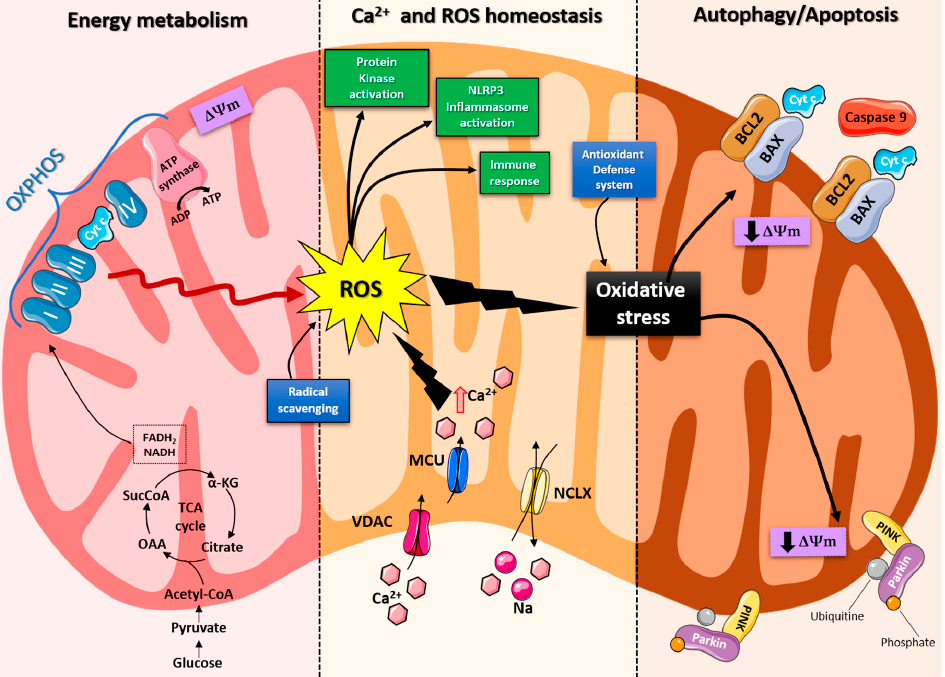
Figure 1 Figure 1. Schematic representation of the mitochondrial functions. From left: Under physiological conditions, mitochondria supply ATP through OXPHOS. Krebs cycle enzymes use acetyl-coenzyme A to reduce NADH and FADH2, which are used for energy transfer to the electron transport chain (ETC) embedded in the inner mitochondrial membrane. OXPHOS is also an important source of ROS, whose basal levels are maintained by the radical scavenging network. Mitochondria also play a crucial role in calcium homeostasis. The voltage-dependent anion channel (VDAC) and the mitochondrial Ca 2+ uniporter complex (MCU) finely control Ca 2+ passage across the mitochondrial membranes, while the mitochondrial Na + /Ca 2+ exchanger (NCLX) is one of the central units involved in Ca 2+ extrusion. Under normal conditions, through ROS generation and redox signaling, mitochondria can control cellular metabolism, physiology, the inflammatory response, and immune function and act as important signaling molecules in the cell by activating various protein kinases. In contrast, the overproduction of ROS and dysregulation of the redox signaling system result in oxidative stress that can lead to mitochondrial damage. Malfunctioning mitochondria can be selectively removed through mitophagy, or, as all other defense mechanisms fail, the neuron can orchestrate its own destruction by activating the intrinsic suicide program of